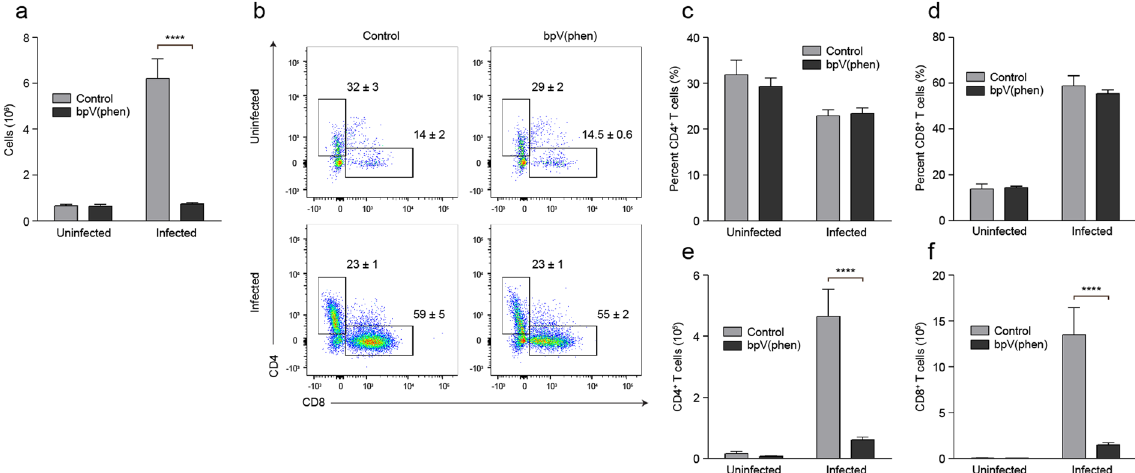
Figure 5. PTP inhibition prevents the brain sequestration of CD4 + and CD8 + T cells. ( a ) Total cells sequestered in the brain, ( b ) representative flow cytometry plots of CD4 + and CD8 + T cells, percentage of brain-infiltrating leukocytes that are ( c ) CD4 + T cells and ( d ) CD8 + T cells, and total brain-sequestered ( e ) CD4 + T cells and ( f ) CD8 + T cells measured on day 7 post-infection. Infiltrating leukocytes are defined as CD11b lo-hi CD45 + cells. The numbers shown on the flow cytometry plots indicate the mean percentage of cells inside the gate ± S.E.M. n = 5 for uninfected, control mice, n = 5 for uninfected, bpV(phen)-treated mice, n = 5 for infected, control mice and n = 8 for infected, bpV(phen)-treated mice. **** P < 0.0001 using a one-way ANOVA and Tukey’s multiple comparisons test.